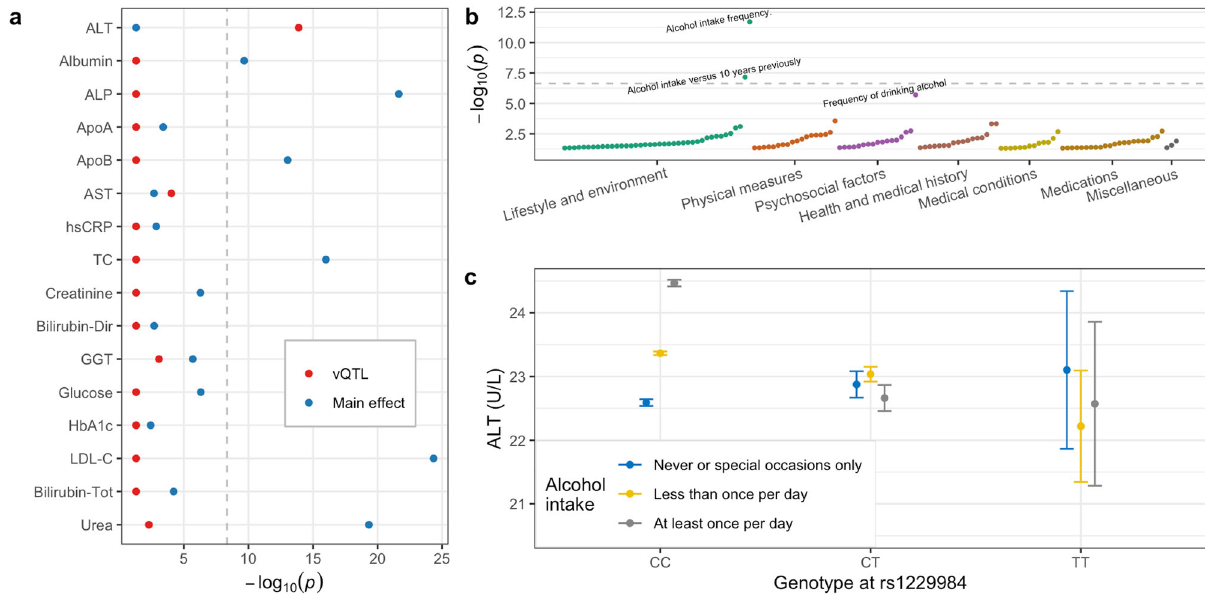
Fig. 5 vQTL and GEI relationships for ADH1B, alcohol, and ALT. a vQTL (red) and ME (blue) signi fi cance for rs1229984 is shown for each biomarker, based on Levene ’ s test and linear regression, respectively. The dashed line represents the study-wide Bonferroni vQTL signi fi cance threshold. Biomarkers with neither vQTL nor ME having p < 0.01 are not shown. b EWIS results for rs1229984 impacting ALT are shown, with GEI signi fi cance plotted ( y axis) for each exposure having p < 0.05 ( x axis). c Means and standard errors for ALT ( n = 341,815 [CC], 17,539 [CT], 318 [TT] participants) are plotted as a function of genotype at rs1229984 ( x axis) and self-reported alcohol intake